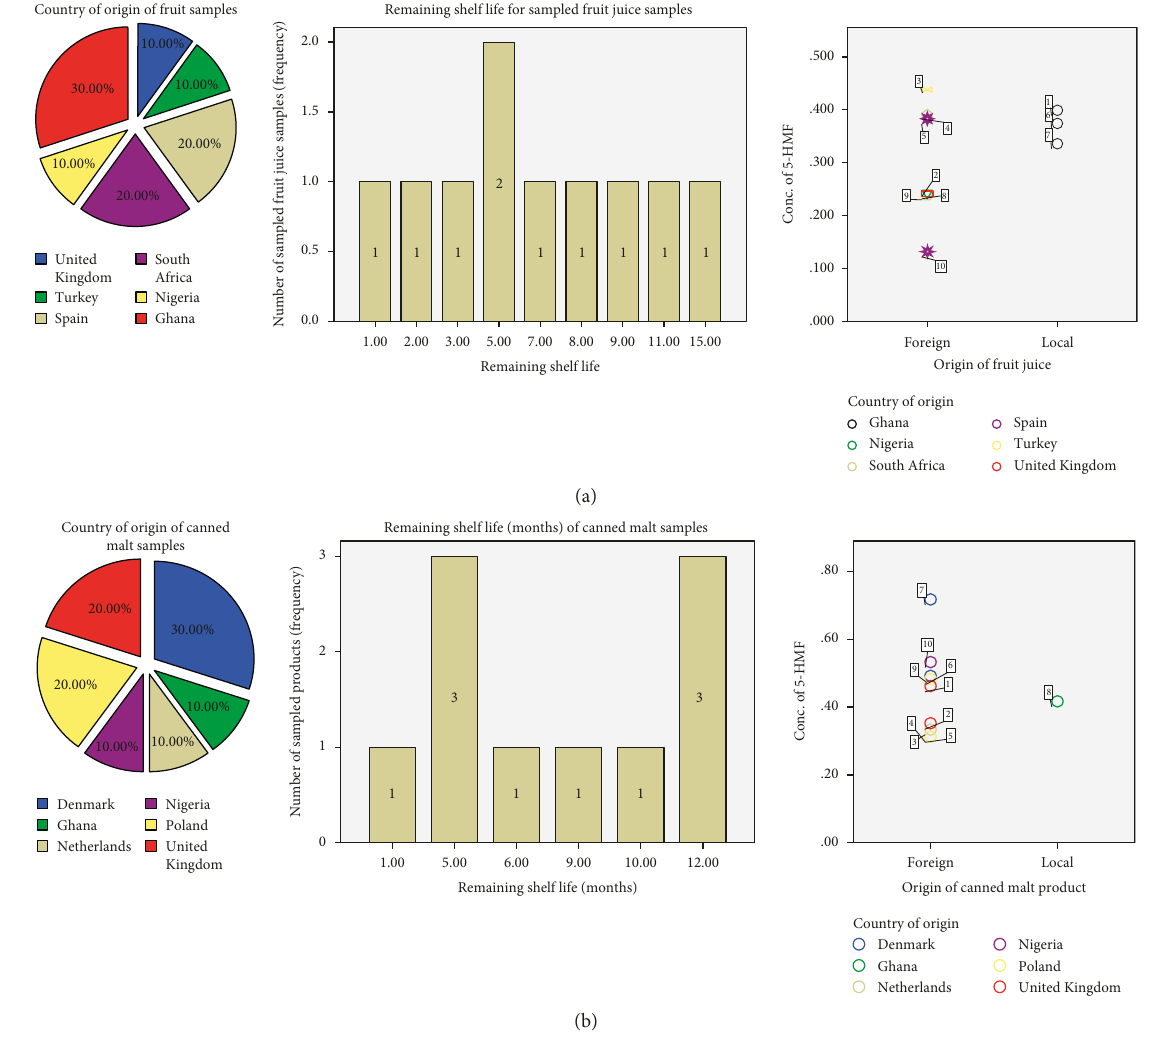
Figure 5: (a) Data generated from fruit juice products sampled from the market ( N juice samples taken were of the Ghanaian origin. Sampled products had 1–15 months remaining of their shelf lives at the time of collection. (b) Data generated from canned malt products sampled from the market ( N samples ( N 1) taken were of the Ghanaian origin. Sampled products had 1–12 months remaining of their shelf lives at the time of (cid:31)